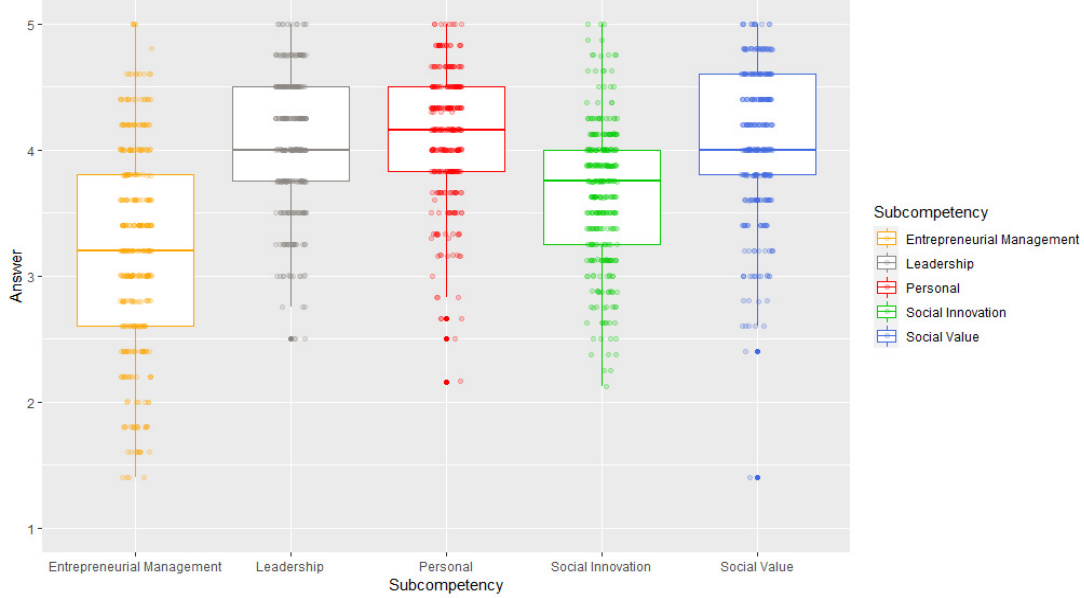
Figure 2. Boxplots of the distribution of mean values of students by type of subcompetency. Source: Created by the authors.